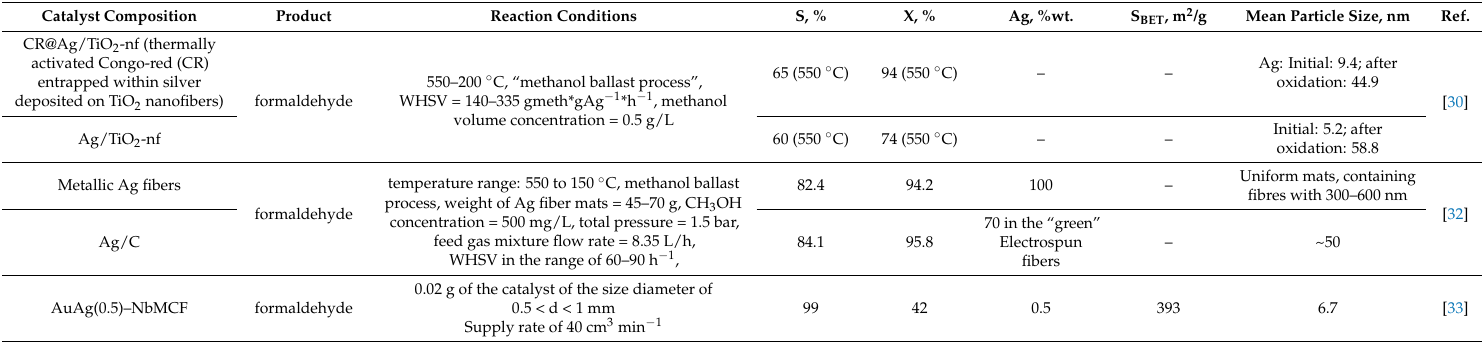
Table 1. Catalysts for selective oxidation of